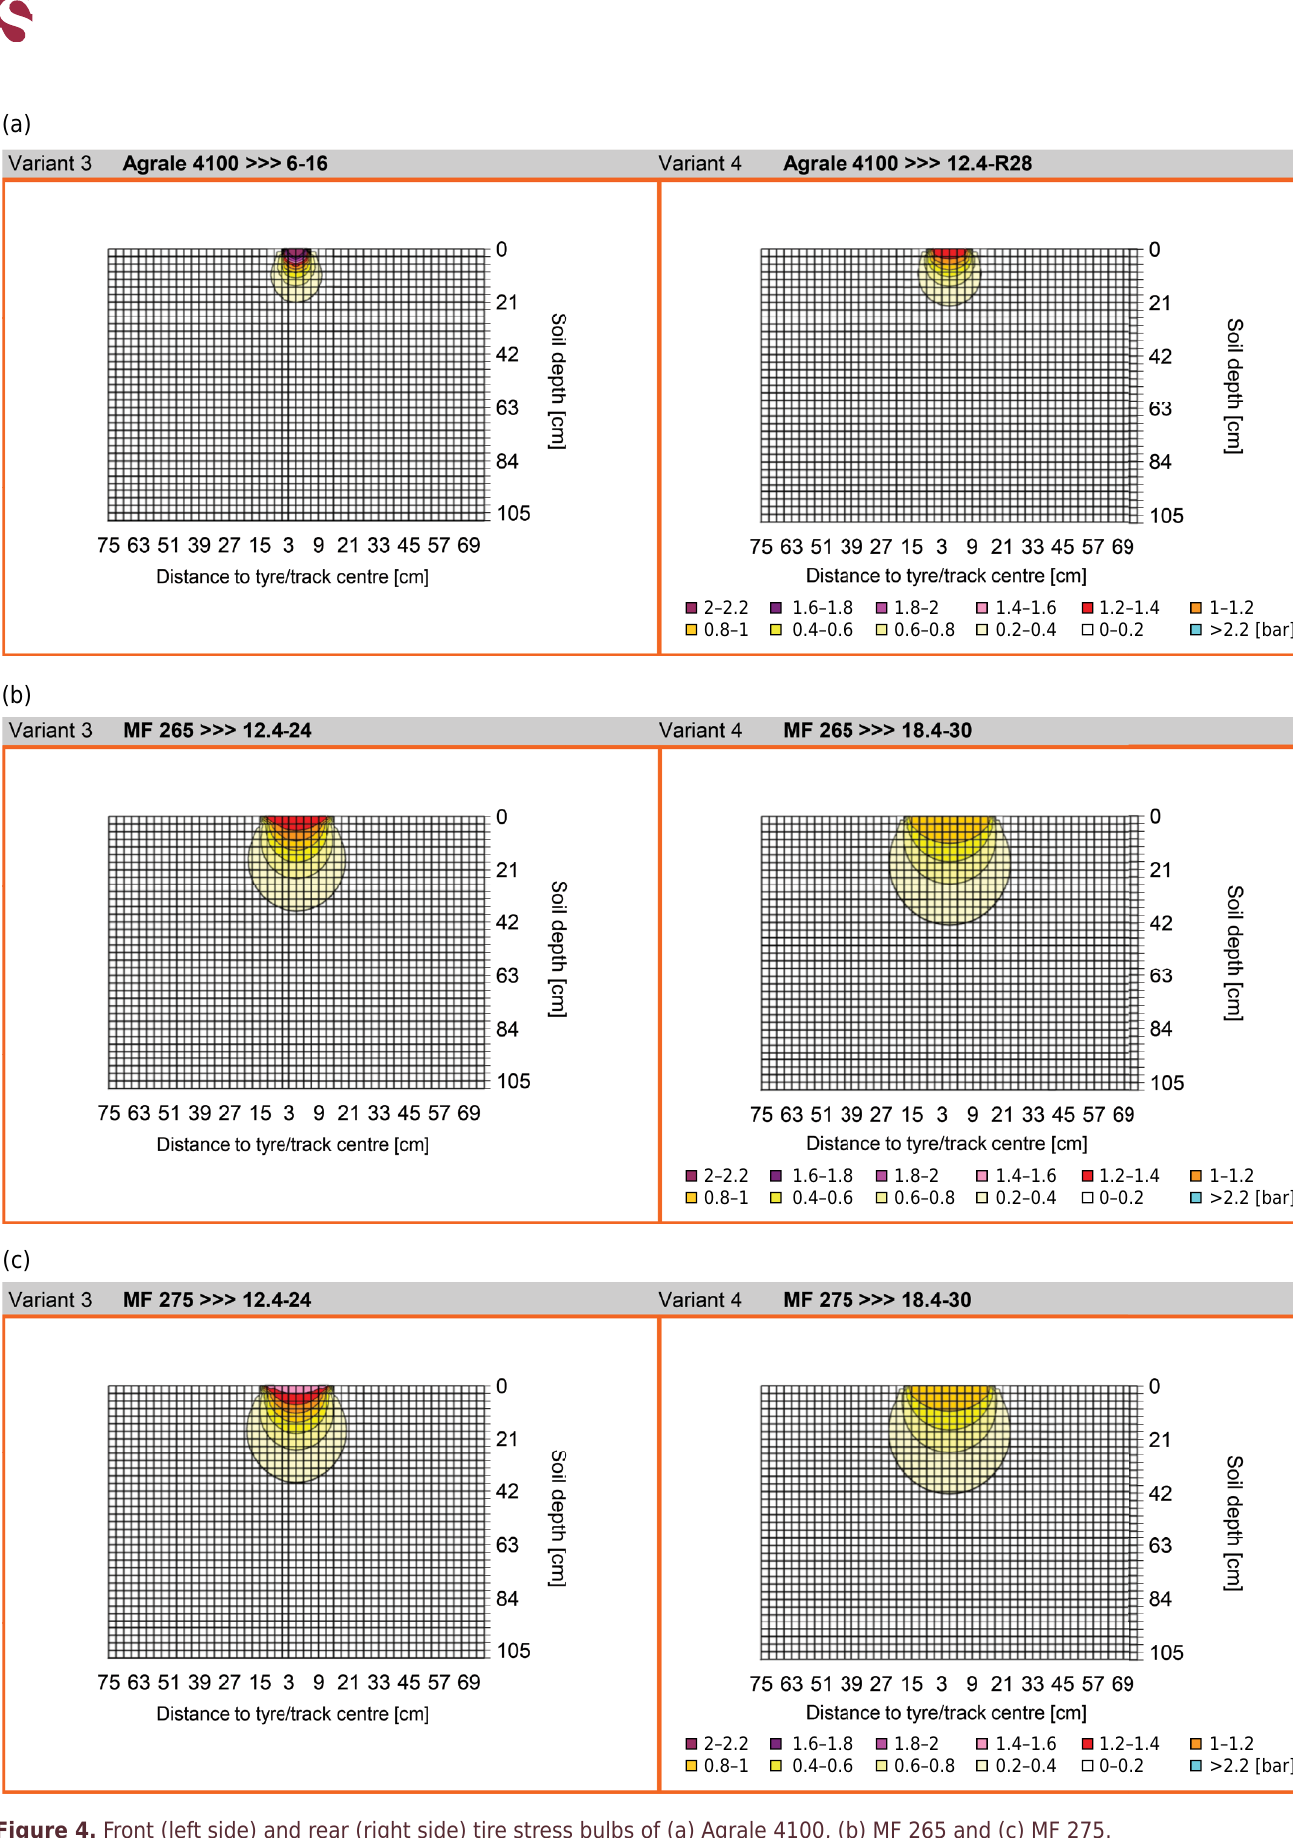
Figure 4. Front (left side) and rear (right side) tire stress bulbs of (a) Agrale 4100, (b) MF 265 and (c) MF